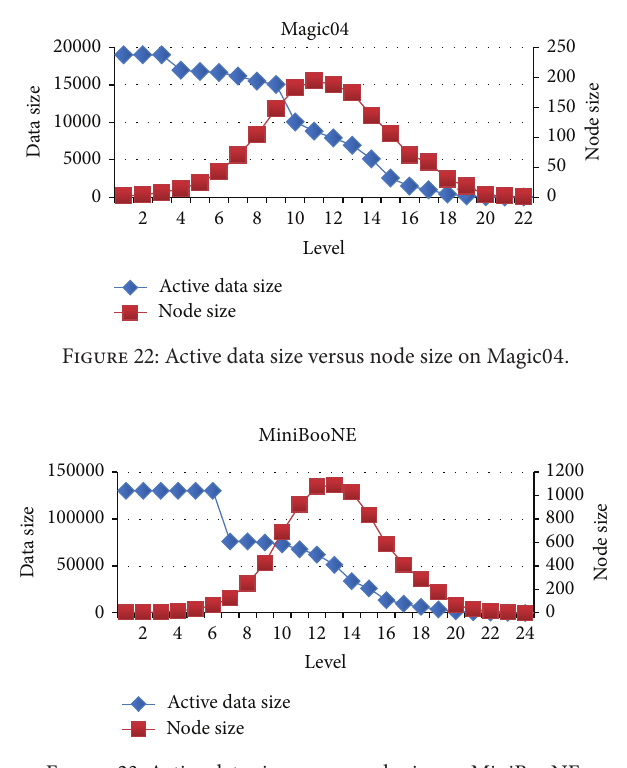
Figure 23: Active data size versus node size on